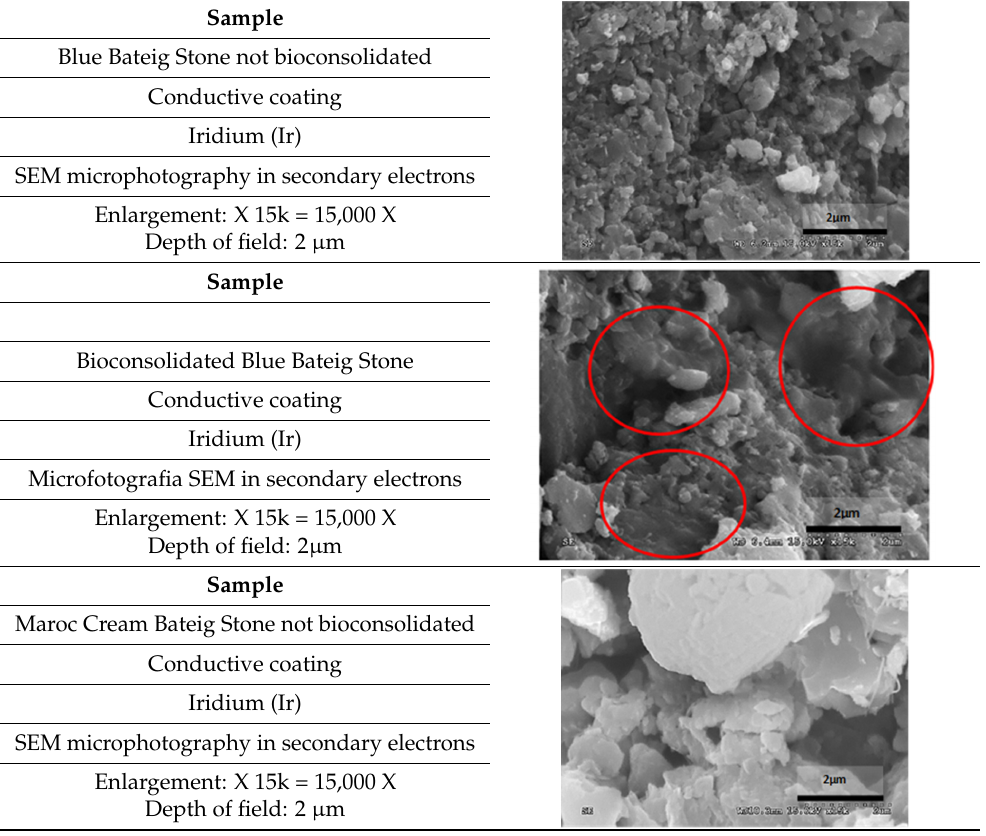
Table 12. Results obtained from microscopic analysis. The red circles indicate the bioconsolidated areas. Sample Blue Bateig Stone not bioconsolidated